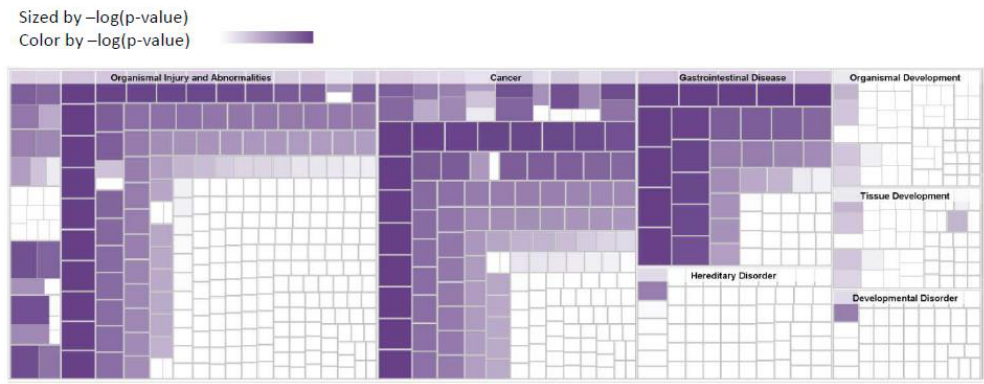
Figure 5. Heatmap for expression analysis in disease and functions.